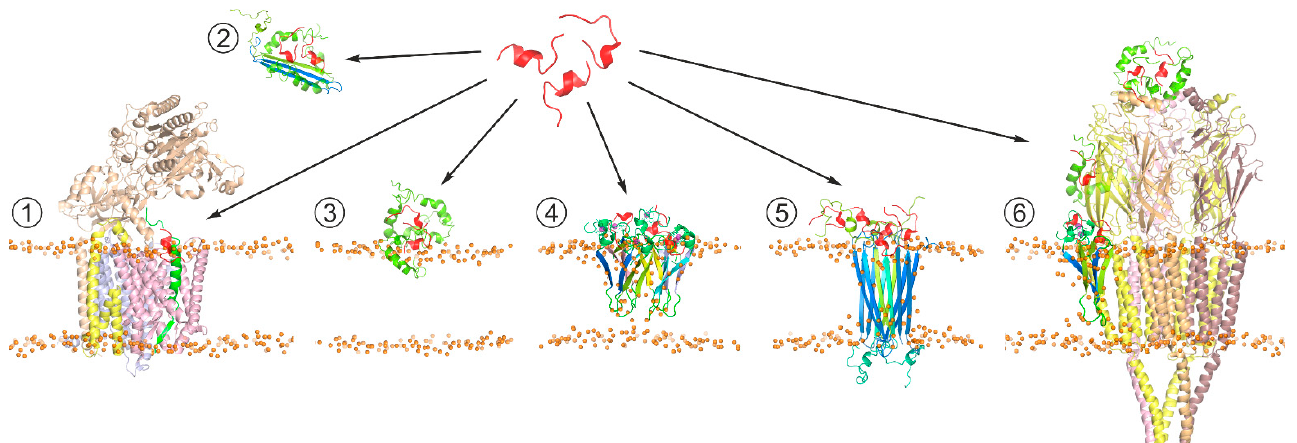
Figure 3. Schematic representation of the generic strategy for search of peptide-based therapeutic agents affecting A β production pathways and/or suppressing neurotoxic effects of A β oligomers. The therapeutic agent (shown in red) can ( 1 ) act at the stage of APP processing through interaction with A β precursors (in green) processed by γ -secretase complex (PDB: 6IYC), modifying production of mature A β isoforms; ( 2 ) bind soluble A β aggregates, suppressing their toxicity; ( 3 ) interfere with interactions of toxic A β aggregates with membrane surface, inhibiting their conversion into β -structured membrane-bound oligomers; ( 4 ) modify toxic properties of membrane-incorporated A β oligomers associated with membrane permeabilization [140]; ( 5 ) target pore-like transmembrane structures formed by A β oligomers (PDB: 6RHY), e.g., inhibiting transmembrane transport of cations; and ( 6 ) prevent A β from inducing abnormal functioning of soluble and membrane-associated proteins, e.g., nicotinic acetylcholine receptor (PDB: 2BG9), which can be inhibited by diverse A β oligomers in different manners.